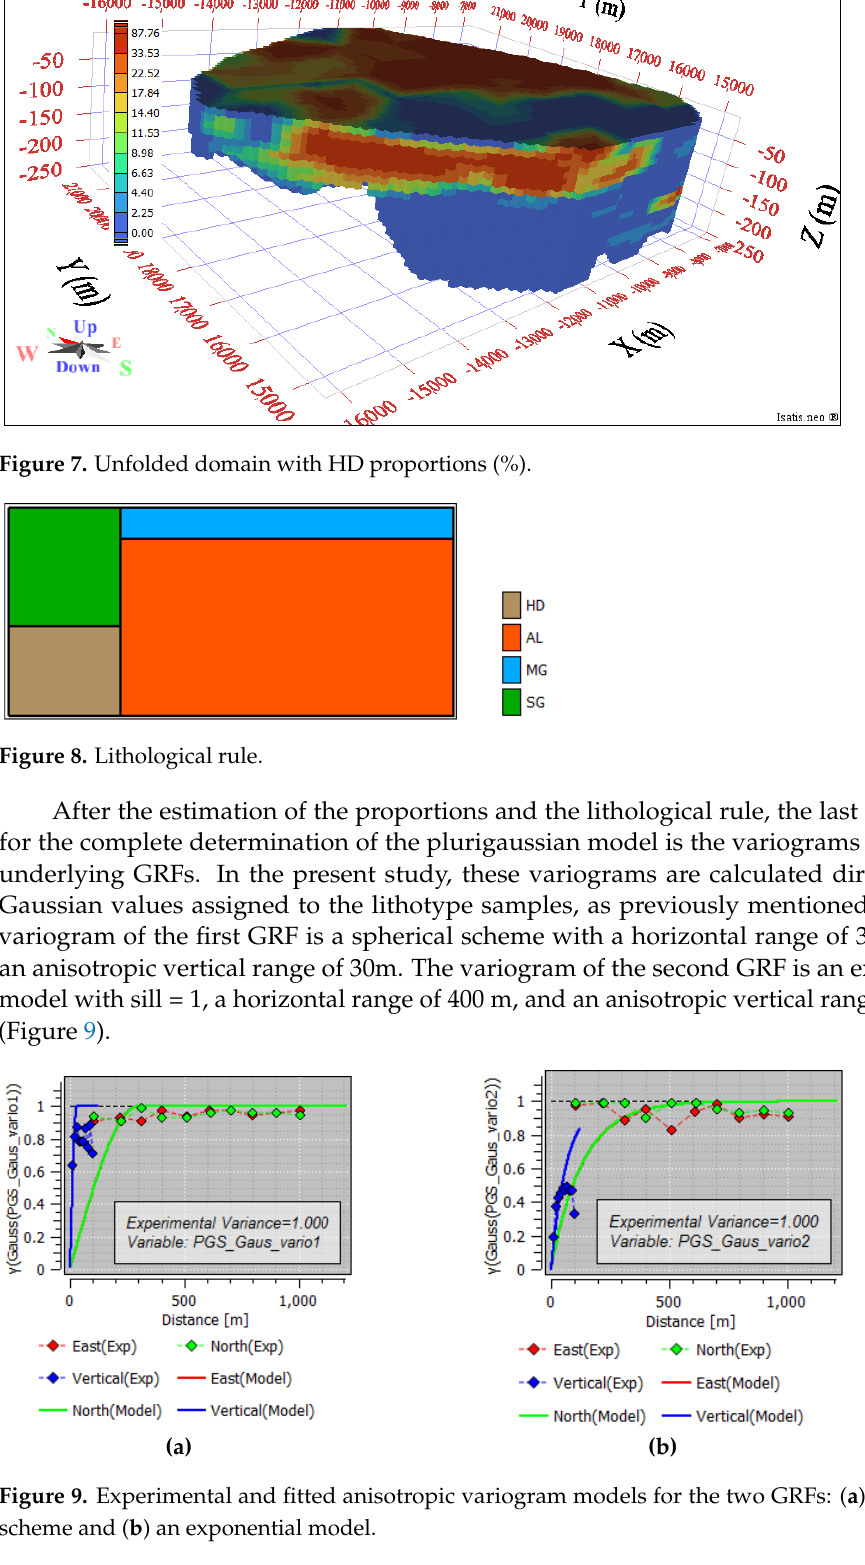
Figure 9. Experimental and fitted anisotropic variogram models for the two GRFs: ( a ) a spherical scheme and ( b ) an exponential model.